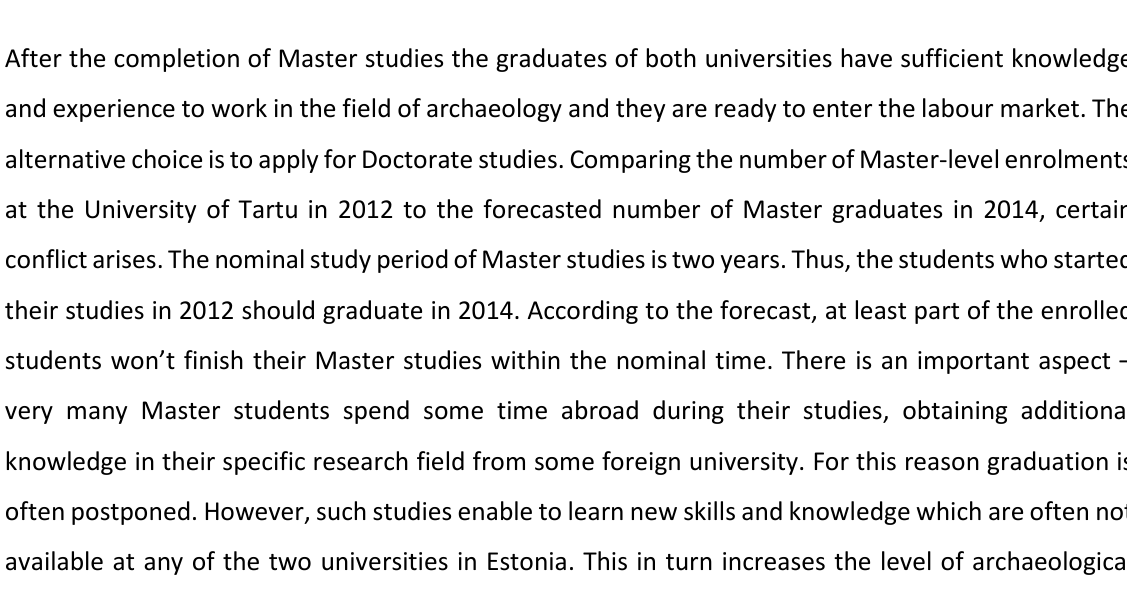
Table 13 - The graduates of Master studies –